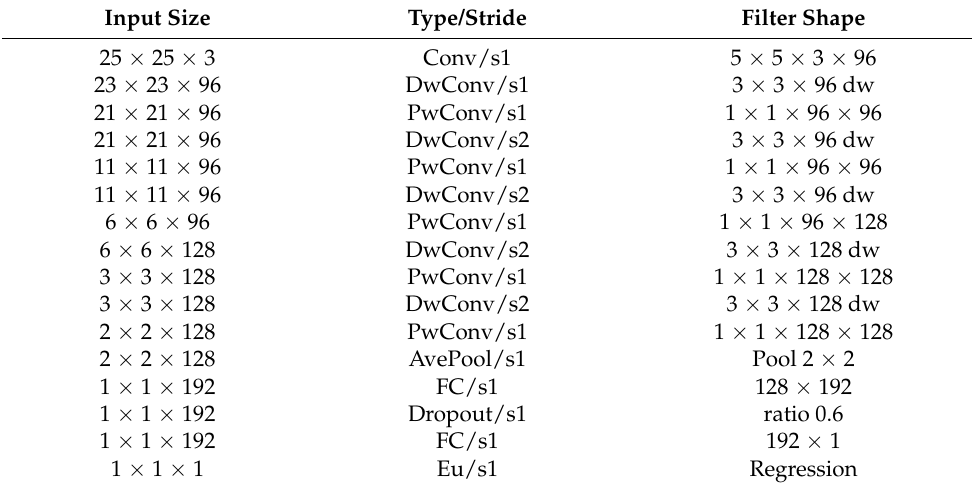
Table 1. EVM-CNN Network Architecture. Input